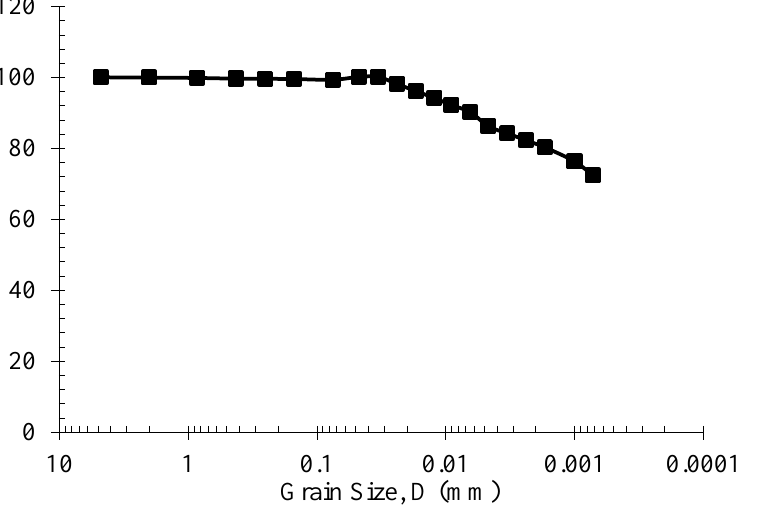
Figure 3. Combined particle size distribution curve of Yazoo clay.